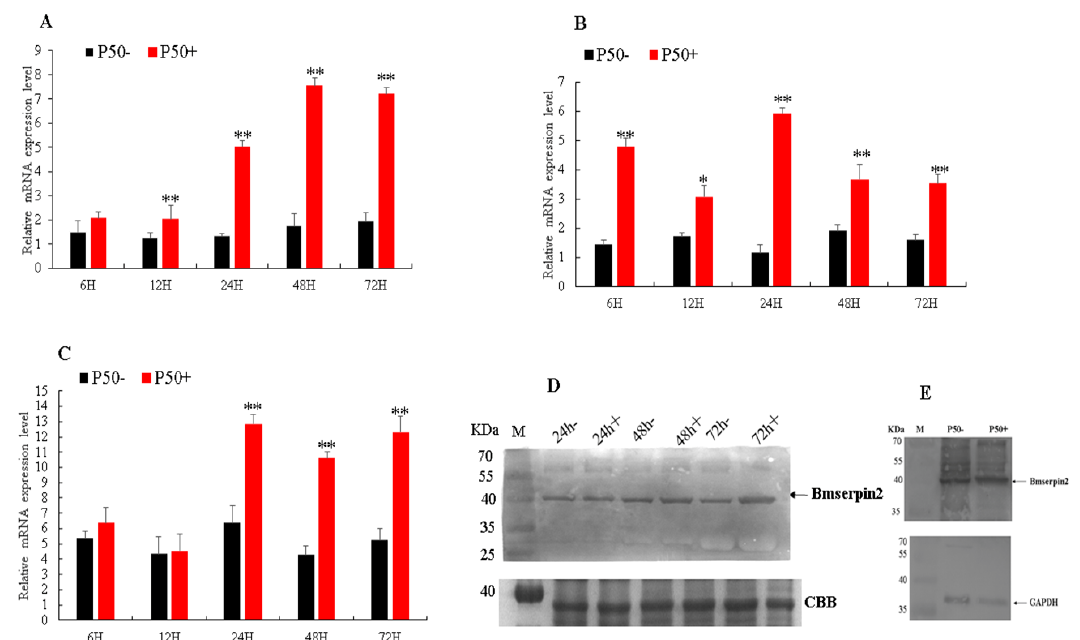
Figure 3. Expression profiles of the Bmserpin2 in P50 (susceptible strain) after Bombyx mori nucleopolyhedrovirus (BmNPV) infection in the haemocytes ( A ), fat body ( B ) and midgut ( C ) at 6, 12, 24, 48 and 72 hpi. P50 − was used as a control. Relative expression levels were calculated using the 2 − ∆∆ Ct method. Statistical analysis was performed using SPSS software (Version 19.0, Armonk, NY, USA). The significant di ff erences are indicated by * ( p < 0.05) or ** ( p < 0.01). Western blot analyses were performed in haemolymph ( D ) at 24, 48 and 72 hpi, total proteins were coomassie brilliant blue (CBB)-stained as the loading control and in midgut ( E ) at 24 hpi. Anti-GAPDH was used as the loading control.